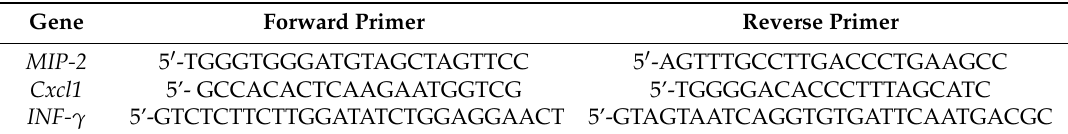
Table 2. Primer sequences used for